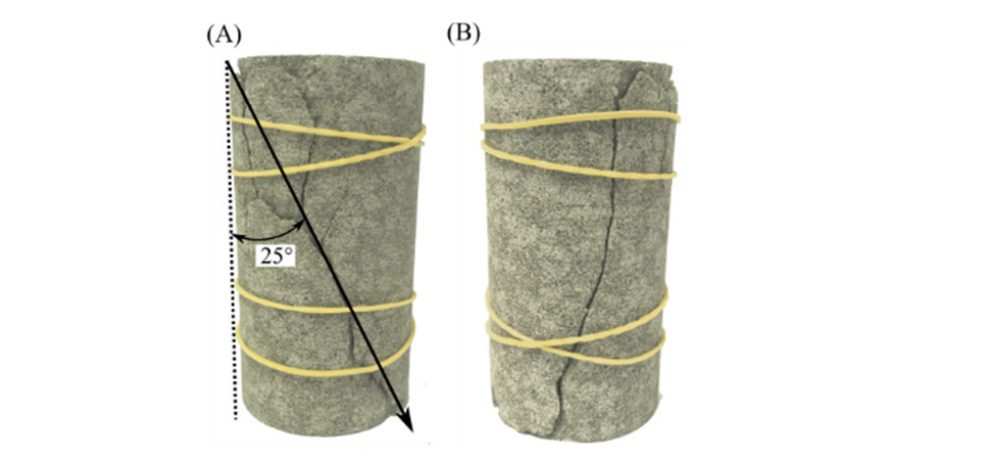
Figure 13. Failure mode of Neijiang sandstone in uniaxial compression strength tests. ( A ) The shear failure angle is about 25 degrees. There are some small cracks around the main fracture. ( B ) A main